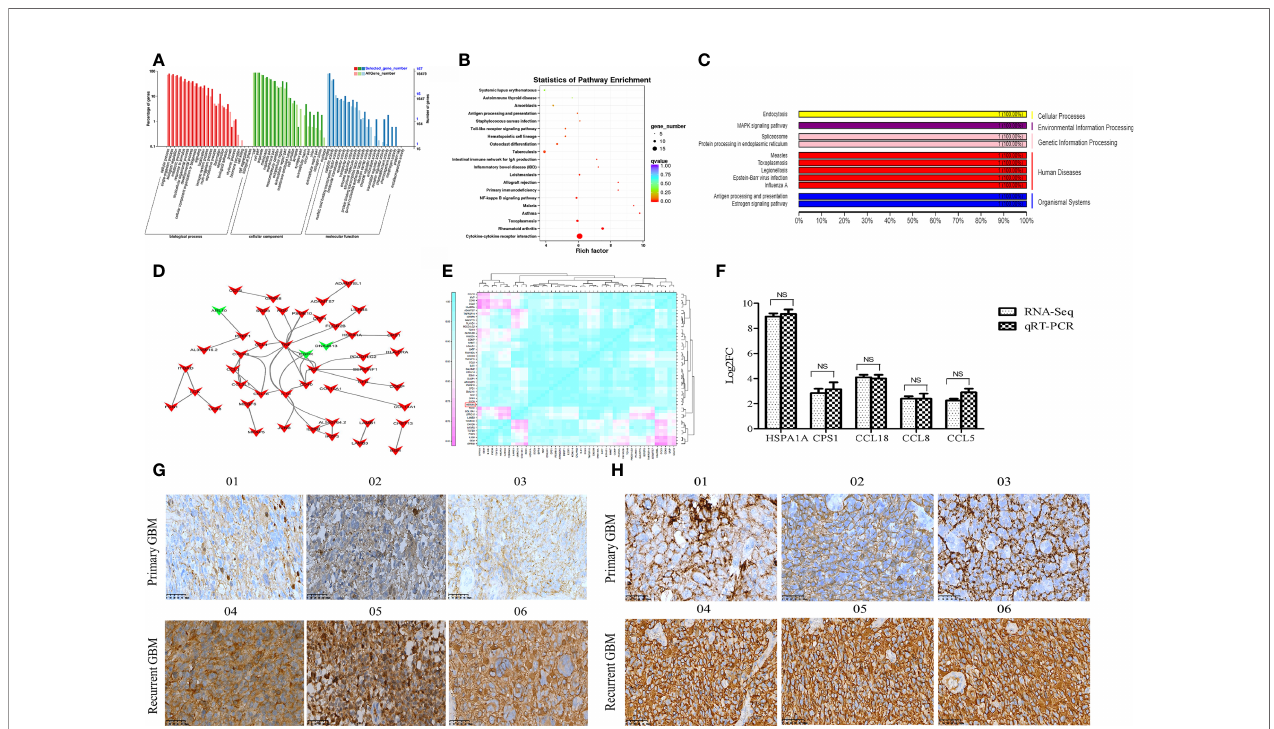
FIGURE 2 | Functional annotation of DEmRNAs and expression validation of selected genes by qRT-PCR and IHC . (A) GO classi fi cation map of DEmRNAs. (B) KEGG functional enrichment map of DEmRNAs. (C) KEGG functional classi fi cation map of mRNA HSPA1A. (D) The PPI map of DEGS mRNA. The DEGs mRNA was indicated by arrows. The up-regulated genes are indicated in red, while the down-regulated genes are indicated in green. (E) Correlation analysis of 47 DEmRNAs highly correlated to HSPA1A. (F) The differential expression of selected mRNAs was validated by qRT-PCR. (G) The IHC image of HSPA1A expression in GBM sample. (H) The IHC image of CPS1 expression in GBM specimens. 01-03 represents primary GBM,04-06 represents recurrent